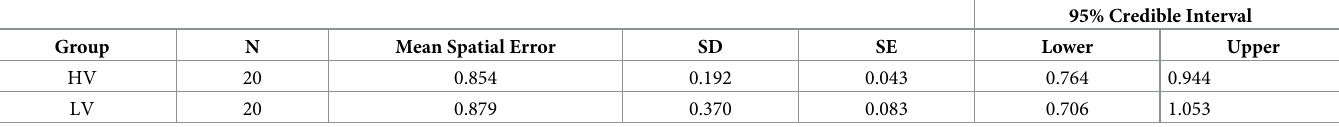
Table 1. Descriptive statistics. Descriptives of the comparison of mean spatial error in HV and LV group of Experiment 2, by means of a Bayesian independent t-test.